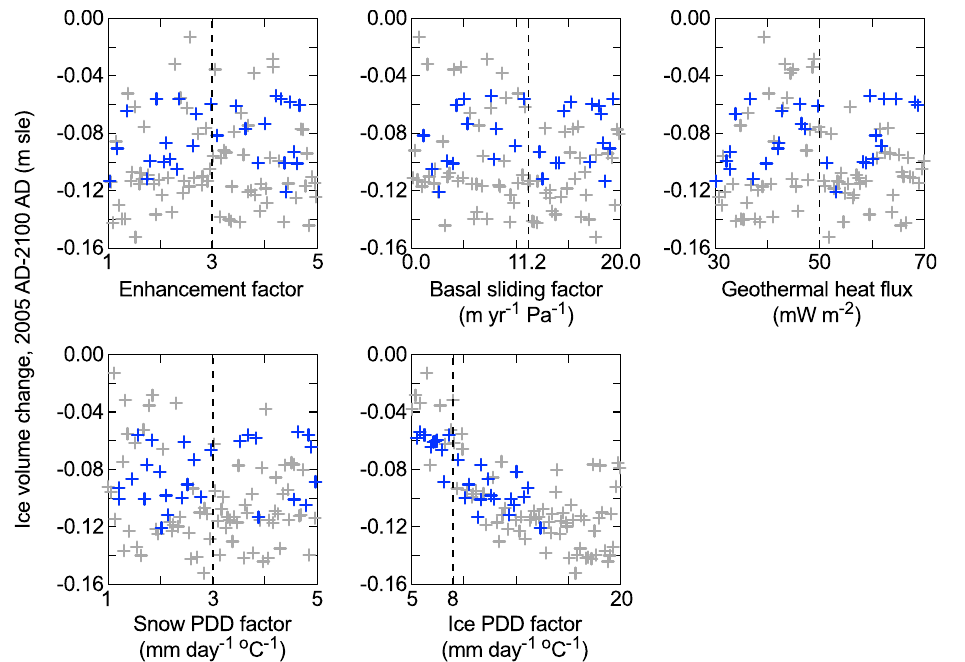
Fig. 6. Relation between input parameter values and simulated ice volume changes between 2005 and 2100 AD (Fig. 3). Color coding is the same as in Fig. 5. The ice positive degree-day factor appears to dominate the short-term future behavior of the model.